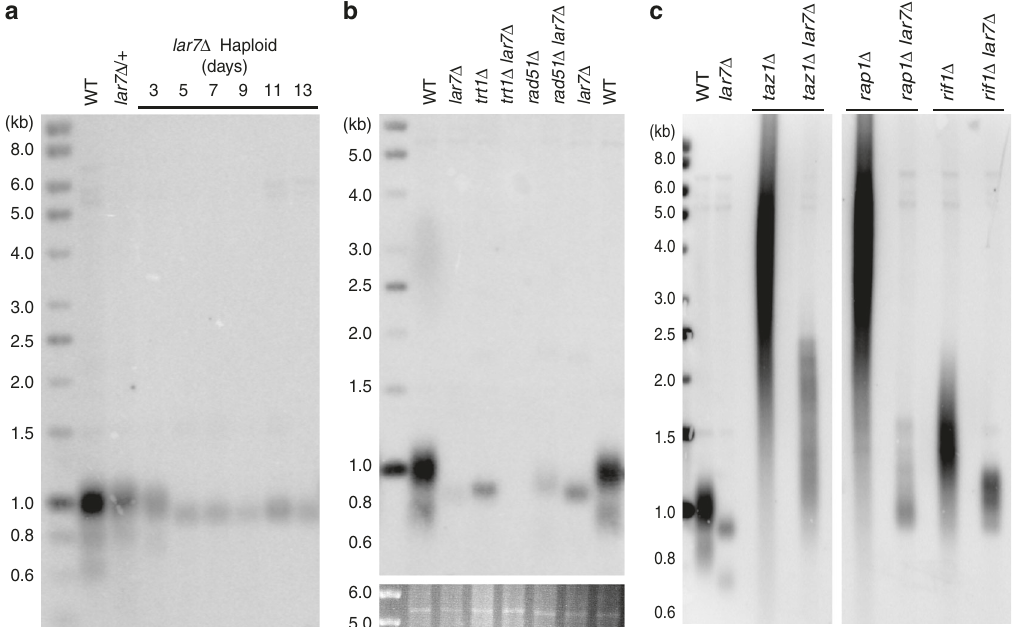
Fig. 1 lar7 Δ impairs telomerase activity. a – c Telomere southern blots of genomic DNA digested with Eco RI and hybridised with a telomeric probe. a Cells heterozygous for lar7 Δ retained telomeres of wild-type length. Haploid lar7 Δ cells were passaged every other day post sporulation and genomic DNA collected at the days stated. b The trt1 and rad51 genes were deleted in wild-type and lar7 Δ strains and passaged for a week. Genomic DNA was collected and subjected to telomere southern blot. c The lar7 gene was deleted in the taz1 Δ , rap1 Δ and rif1 Δ strains and cells were passaged for a week. Genomic DNA was collected and subjected to telomere southern